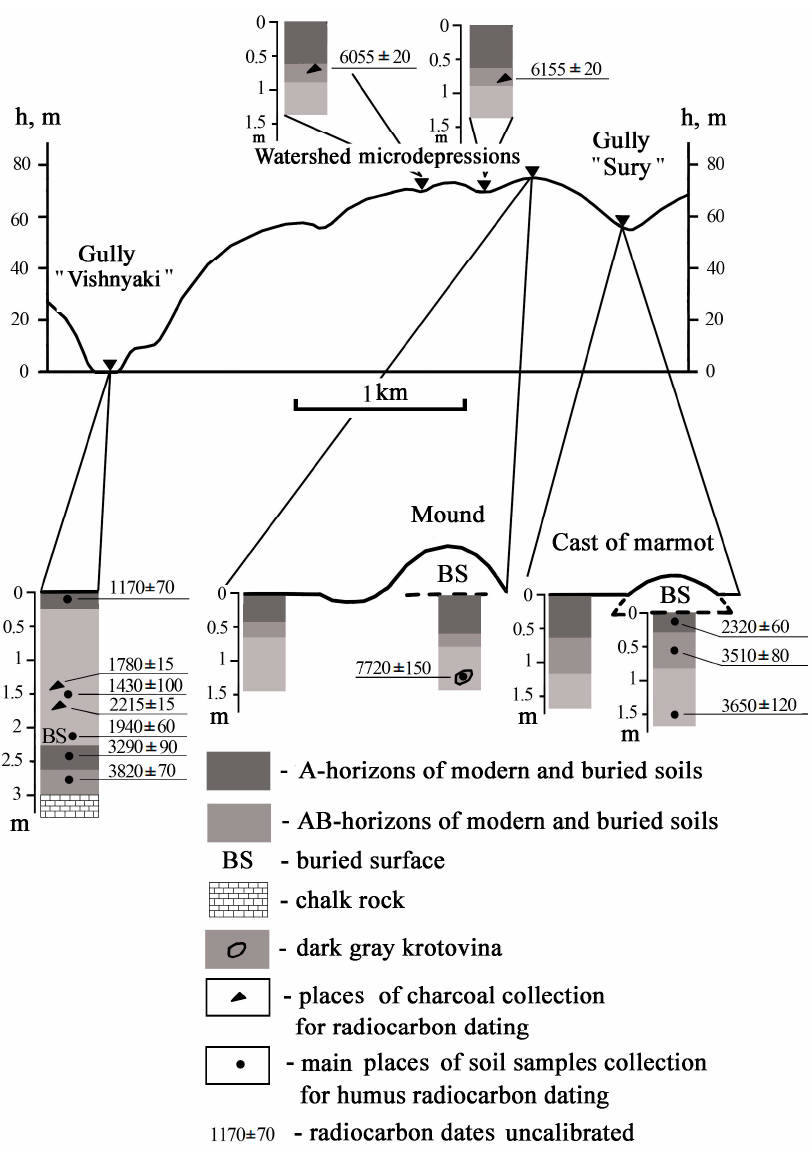
Figure 3. Radiocarbon dated objects in studied soils.